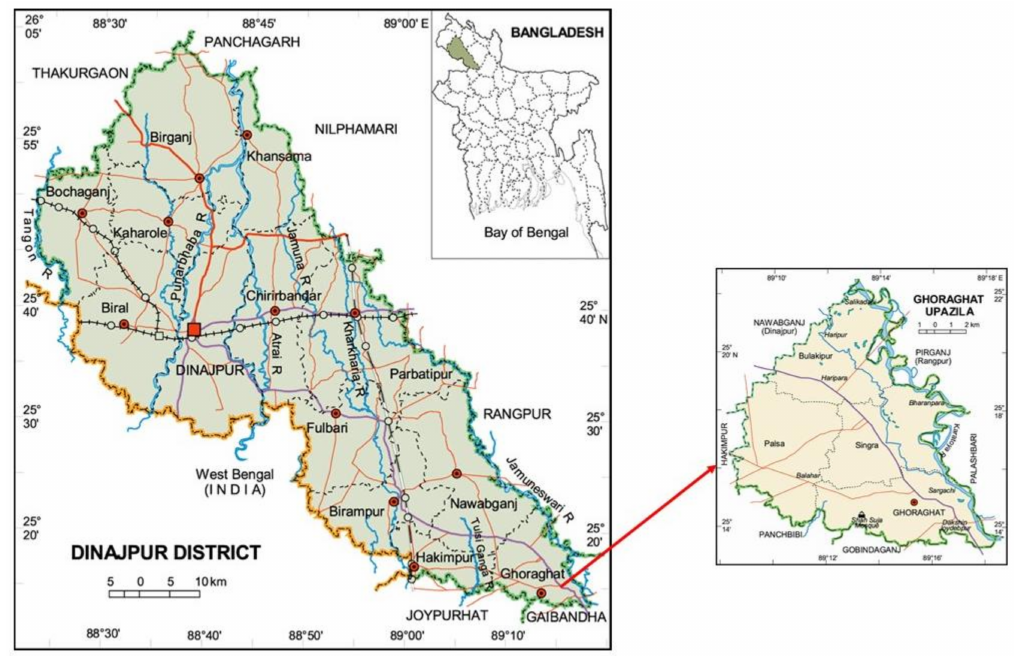
Figure 2. The study